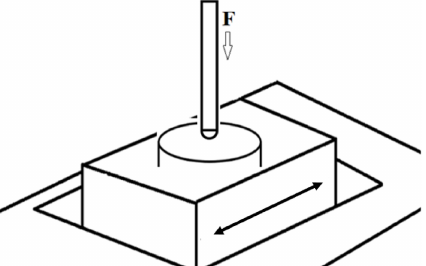
Figure 3: View of ball-on-disc